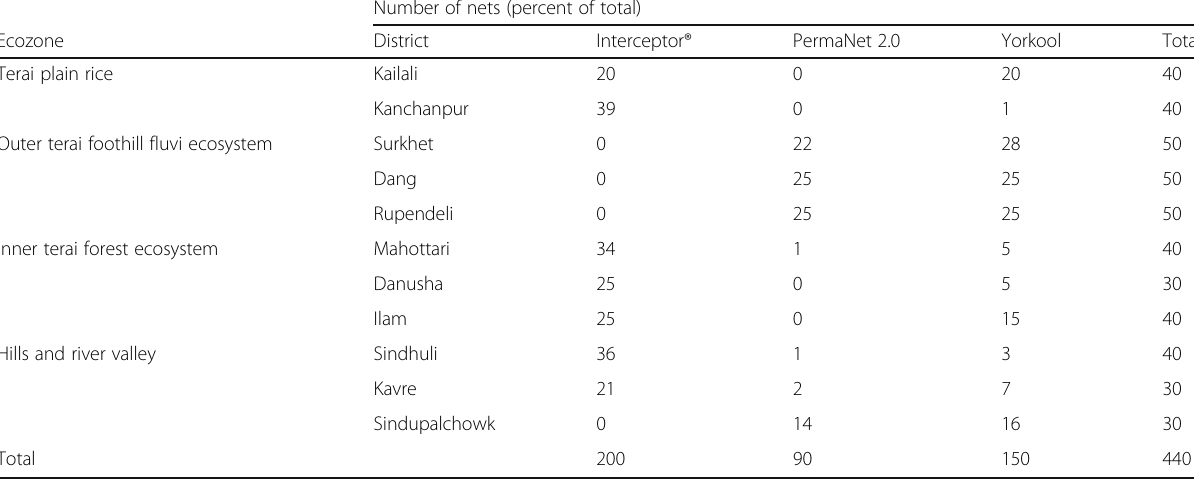
Table 1 Number of field-distributed nets sampled per campaign brand by district Number of nets (percent of total) Ecozone District Interceptor® PermaNet 2.0 Yorkool Total Terai plain rice Kailali 20 0 Kanchanpur 39 0 40 Outer terai foothill fluvi ecosystem 0 Dang Rupendeli 0 Inner terai forest ecosystem Mahottari Danusha Ilam Hills and river valley Sindhuli